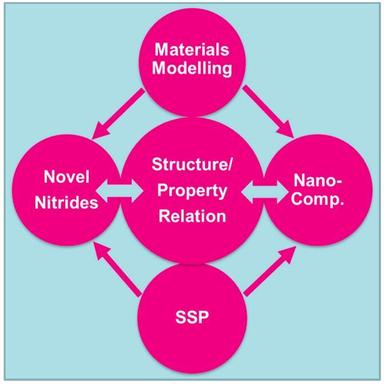
Conceptual structure of our nitride high-pressure research approach: Multifunctional inorganic nitrides will be theoretically predicted (Materials Modelling) and synthesized from single-source precursors (SSP). From the SSPs, novel high-pressure nitrides and nitride-based (nano)composites will be formed under high P/T conditions and analyzed for their structure/microstructure property relations.